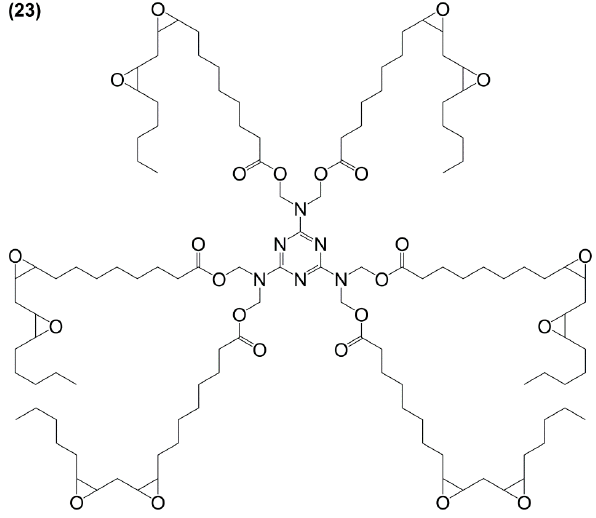
Figure 18. Structure of the glycidylated hexa(linoleoyl hydroxymethyl) melamine [153]. Table 1. Mono-aromatic, di-epoxy monomers and thermal properties of the cured materials. T g values are indicated in plain text, T α are in italics.